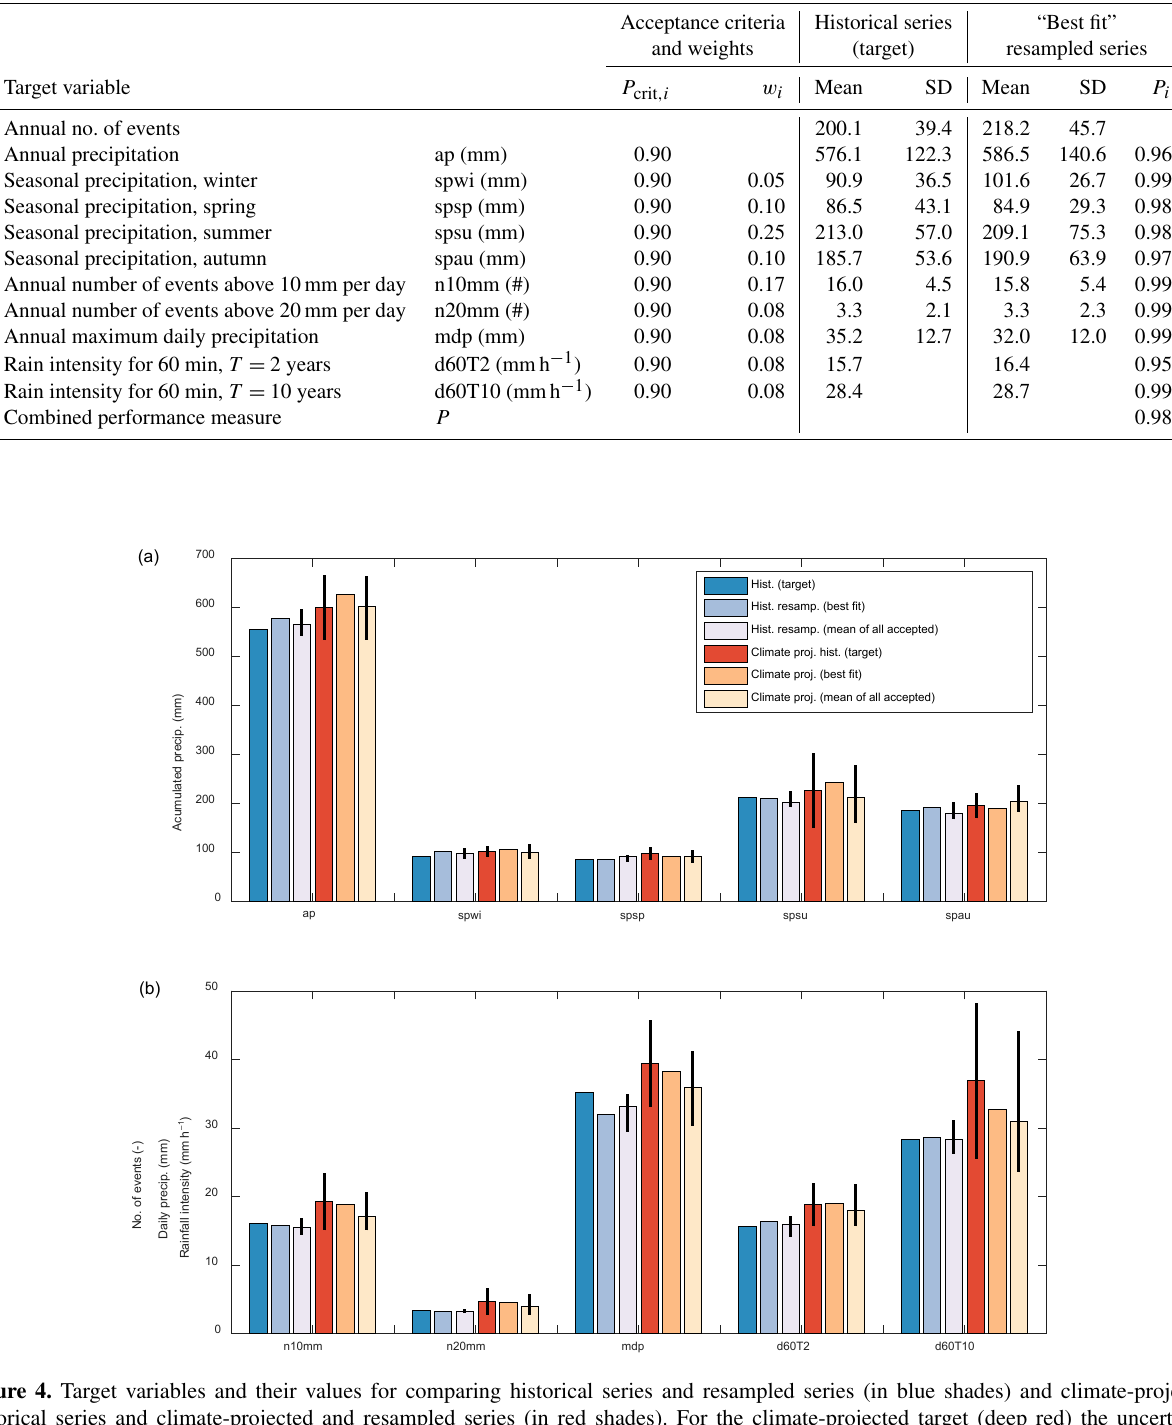
Table 4. Target variables (mean and standard deviation) and performance measures for the historical series and the one resampled series with the highest performance measure.